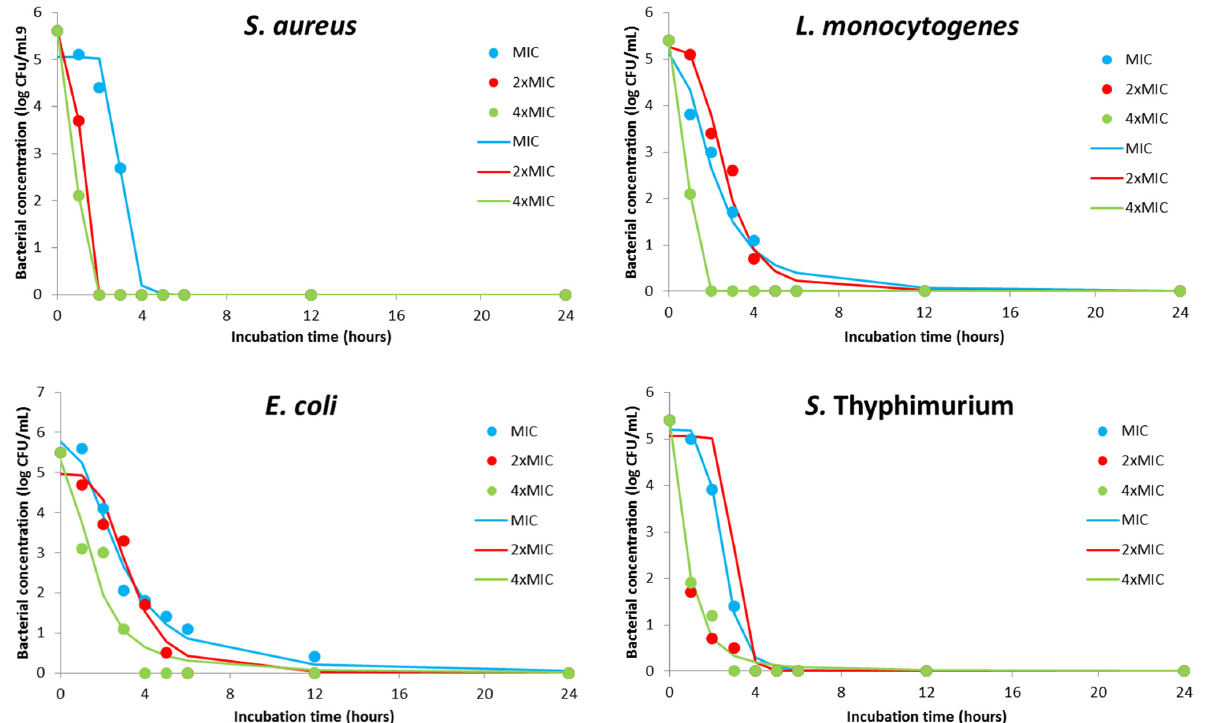
Figure 2. Kinetics modeling for pharmacodynamics potential of antimicrobial activity using MIC, 2×MIC, and 4×MIC of DMEO (markers signify the experimental data; lines indicate predictive results).